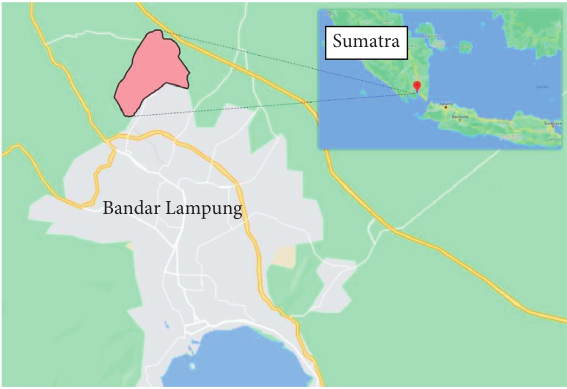
Figure 1: Geographical location of the experimental